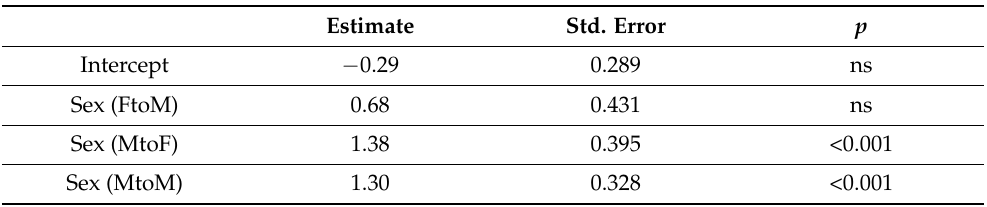
Table 2. Estimates from the Poisson regression for the number of times an individual showed anxiety during the 10 min Zoom session.